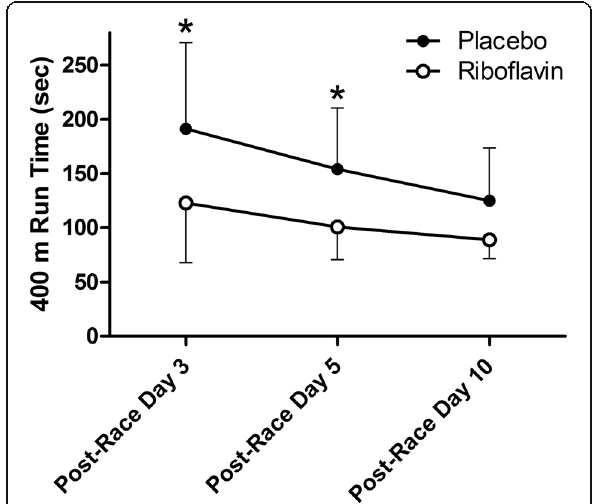
Fig. 2 Mean 400-m run times for the 2 groups. * p < .05 for post- testing group comparison. Error bars represent 1 SD and are shown only in 1 direction for